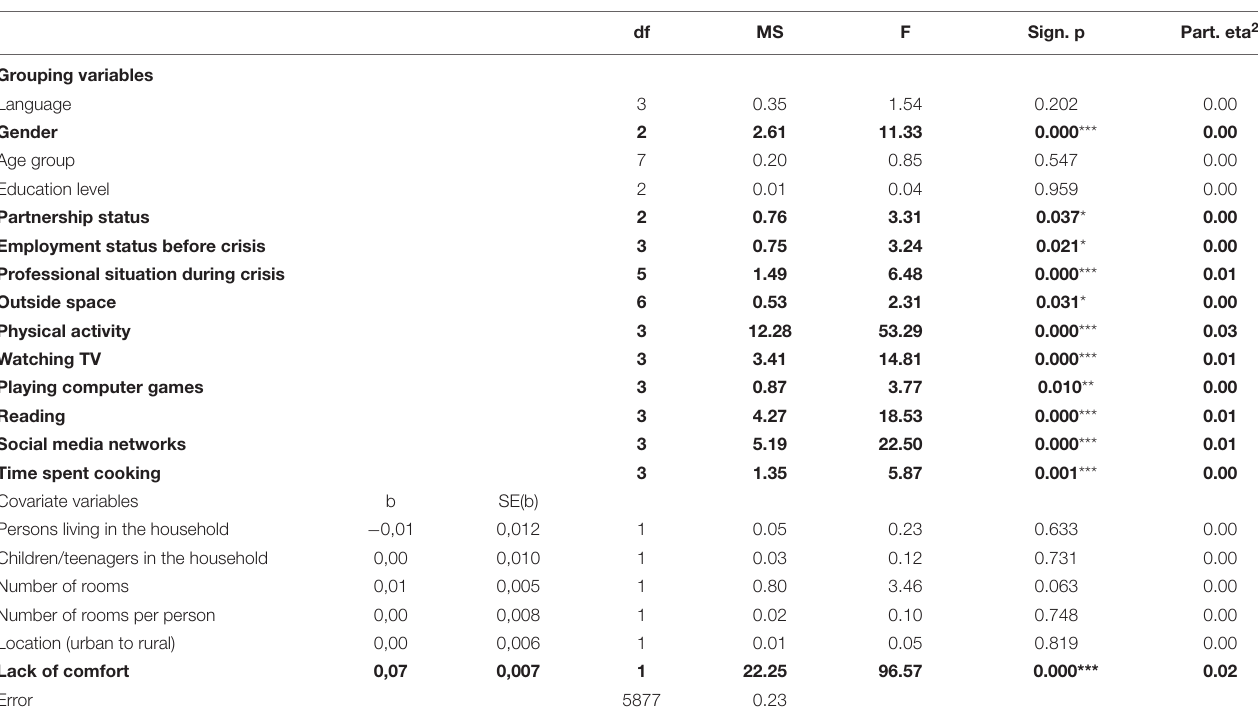
TABLE 4 | ANCOVA model explaining subjective psychological strain.